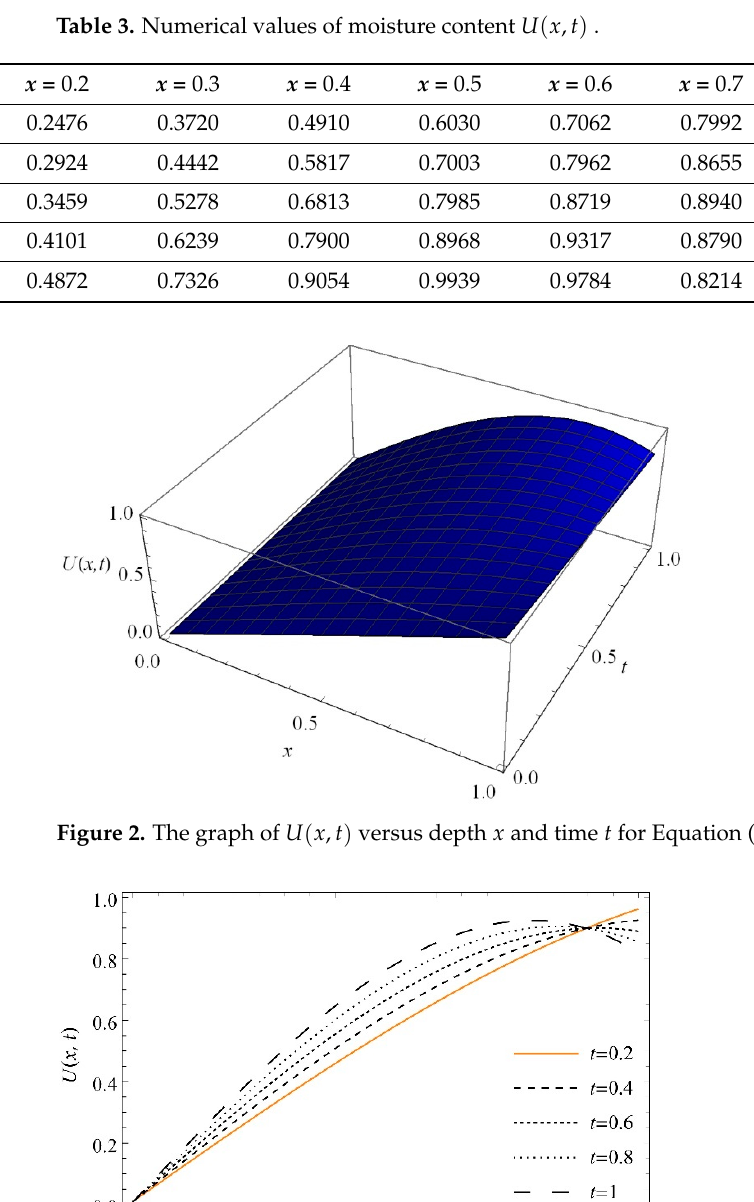
Figure 4. The graph of 𝑈(𝑥,𝑡) versus depth 𝑥 at 𝑛 = 1, 𝑡 = 0.1 , and for 𝛼 = 1, 0.75, 0.50 for Equation (29).